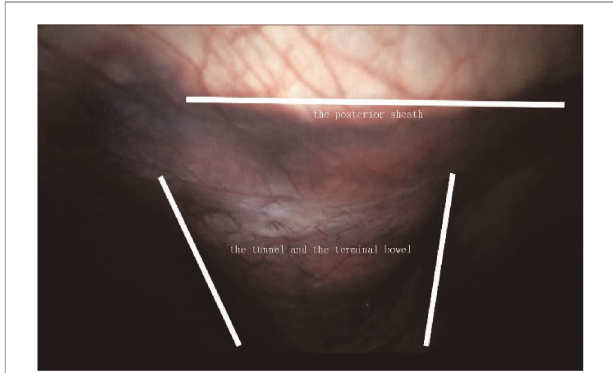
FIGURE 4 | Stoma route.